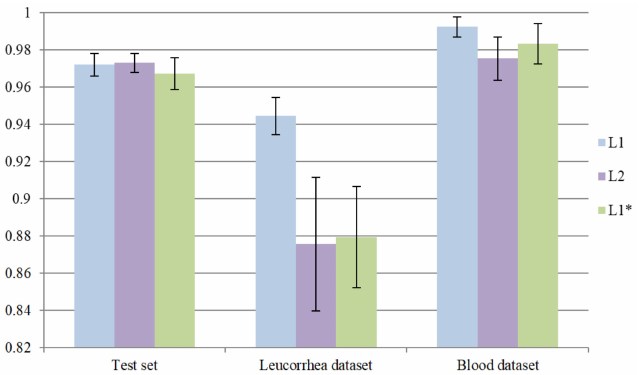
Figure 9. The effectiveness of introducing MA into the network with different depths.